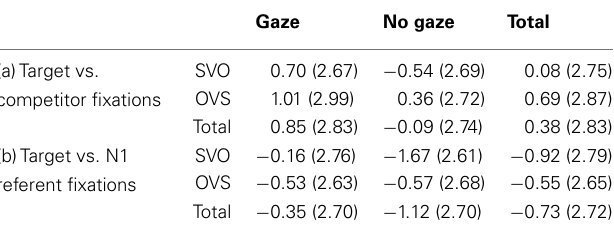
Table 5 | Experiment 2, SHIFT time window: Mean log-gaze probability ratios by condition for fixations to the target character (a) over the competitor or (b) over the NP1